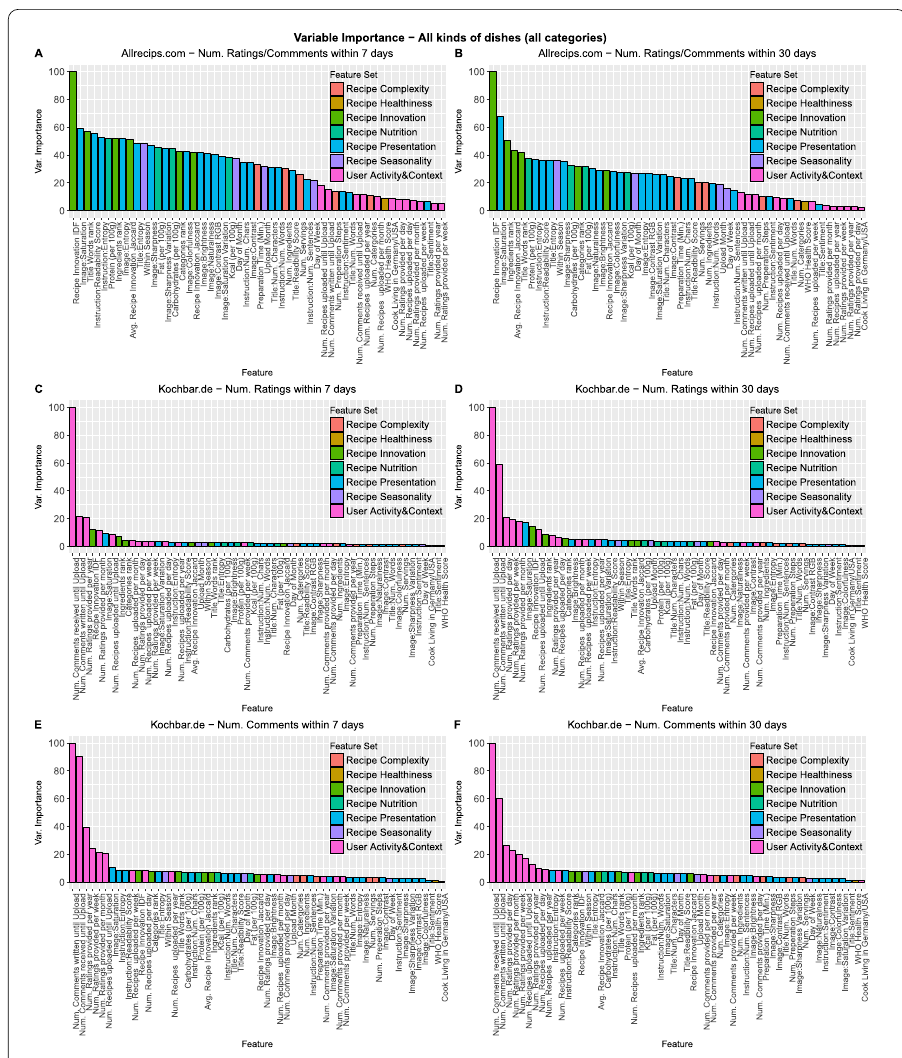
Figure 10 Variable importance for the within one week and month prediction experiments performed on all kinds of dishes. Color coding is used to group the features into the 7 feature classed investigated. While it is the features based on ‘recipe innovation’ and ‘presentation’ which are the most important ones in Allrecipes.com, it is the ‘user activity & context’ set which is the most important one in Kochbar.de. The